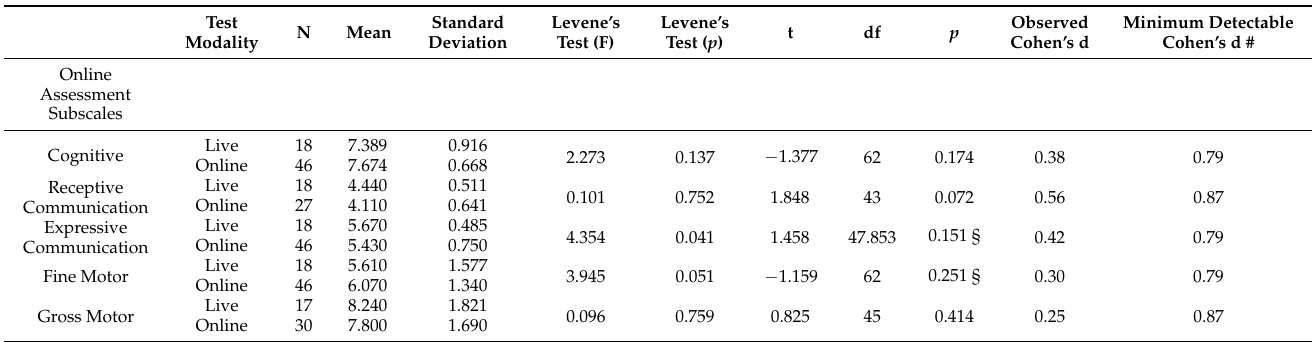
Table 2. The table reports, for each subscale of the online developmental assessment, the descriptive values of the raw scores of the subset of BSID-III items administered remotely to the “online” partici- pants and of the same subset of BSID-III items administered in presence to the “live” participants, along with the statistical values for the comparisons between the two groups (Levene’s test, Student’s t -test, Observed and Minimum detectable Cohen’s